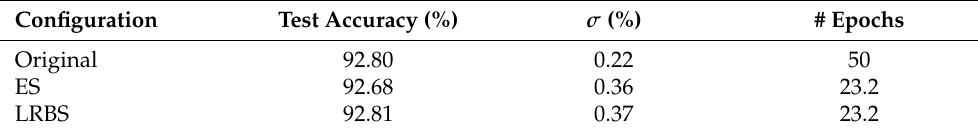
Table 6. Results on MedMNIST2D OrganSMNIST dataset in maximum 50 epochs.